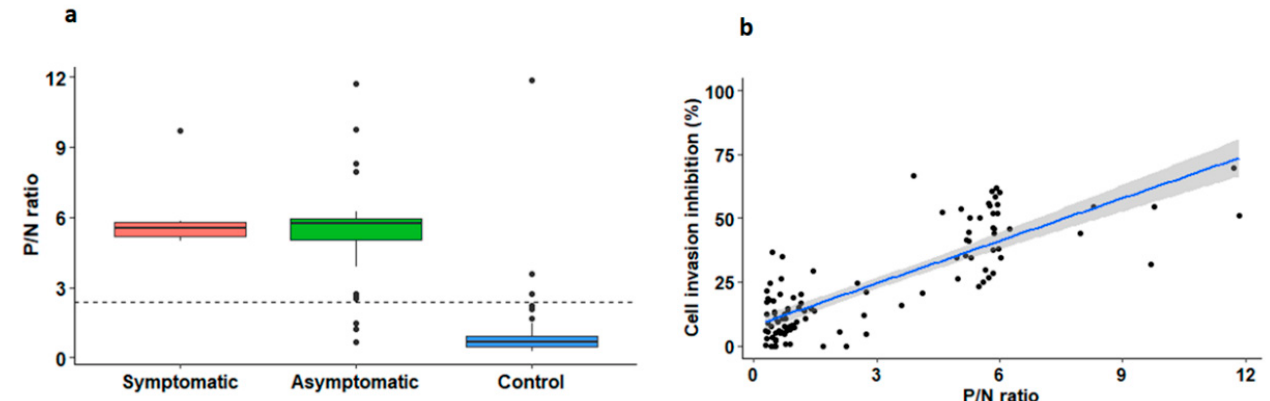
Figure 3. Inhibition of parasite cell invasion is associated with a stronger humoral response against T. cruzi . ( a ) Box plot of P/N ratios of the non-infected controls and T. cruzi -infected subjects with chronic manifestations of disease or in the indeterminate asymptomatic stage. ( b ) Inhibition of cell invasion in relation to P/N ratios obtained in the in-house ELISA. The dotted line in ( a ) represents the P/N positivity cut-off value for the in-house ELISA of 2.4, according to the ROC calculation. The blue line in ( b ) is the regression line and the gray area, the CI95% of the linear regression. parasite invasion more effectively (R 2 = 0.66, p < 0.0001; Figure 3b). This result